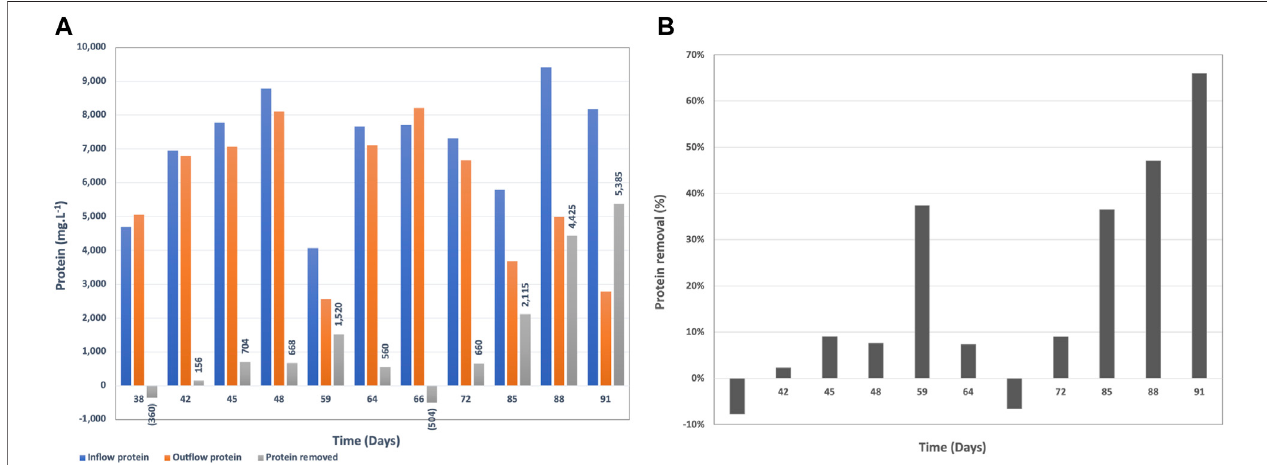
FIGURE 5 | Protein removal rates in (A) mg/L and (B) percentage during continuous